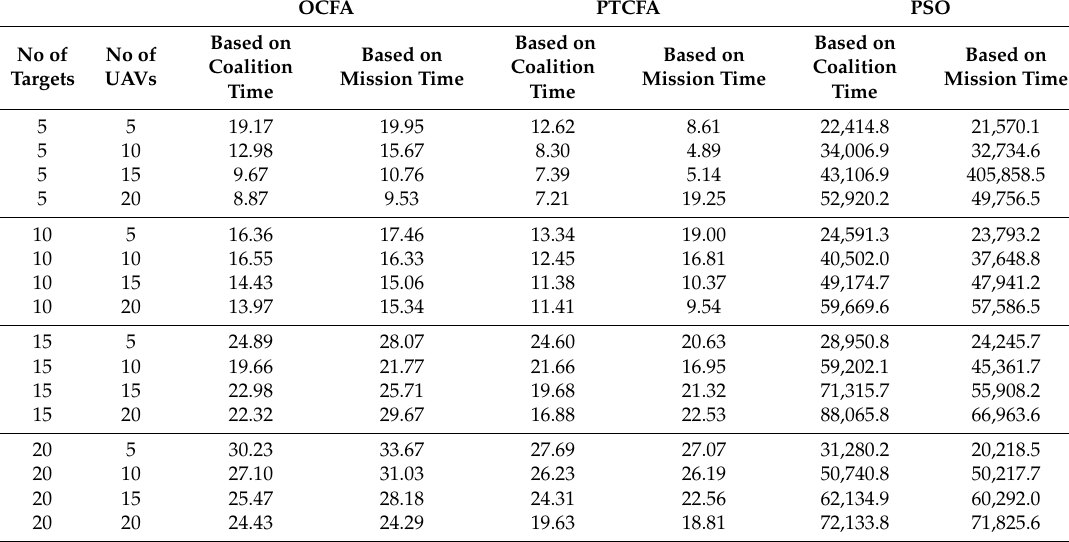
Table 1. Simulation times in milliseconds of the optimal coalition formation algorithm (OCFA), the polynomial time coalition formation algorithm (PTCFA) and particle swarm optimization